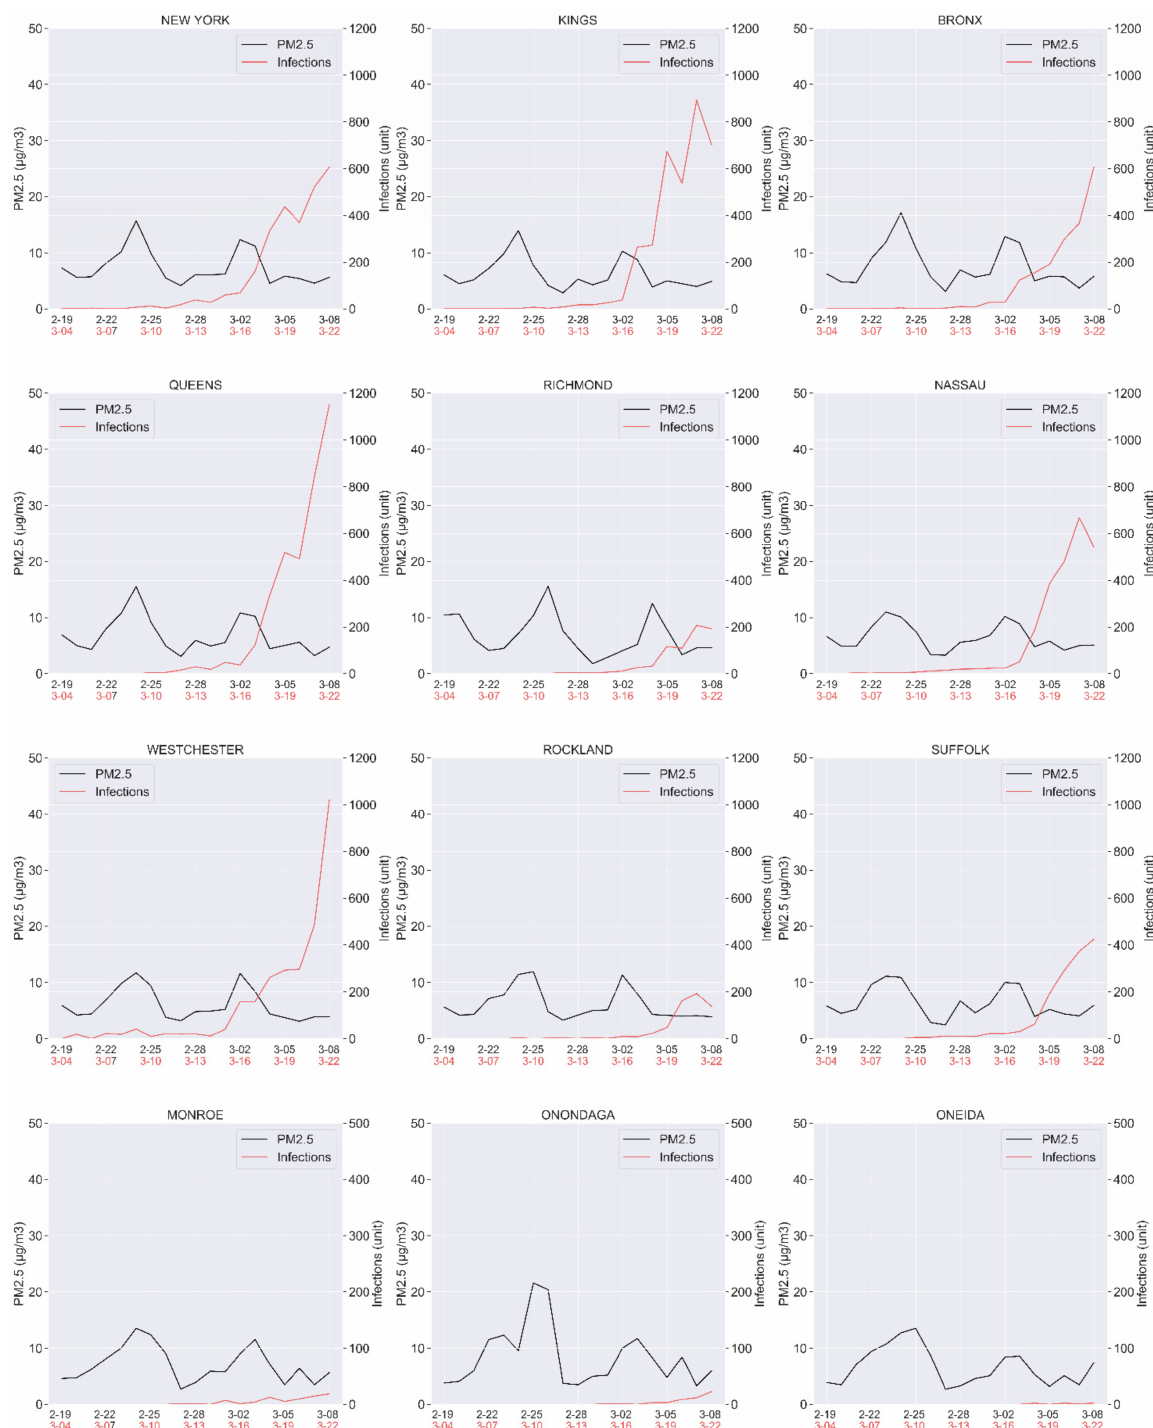
Figure 1. PM2 2.5 and relative period (blue) vs. COVID-19 infections and relative period